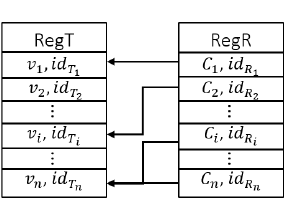
Figure 2. Two registration data tables.